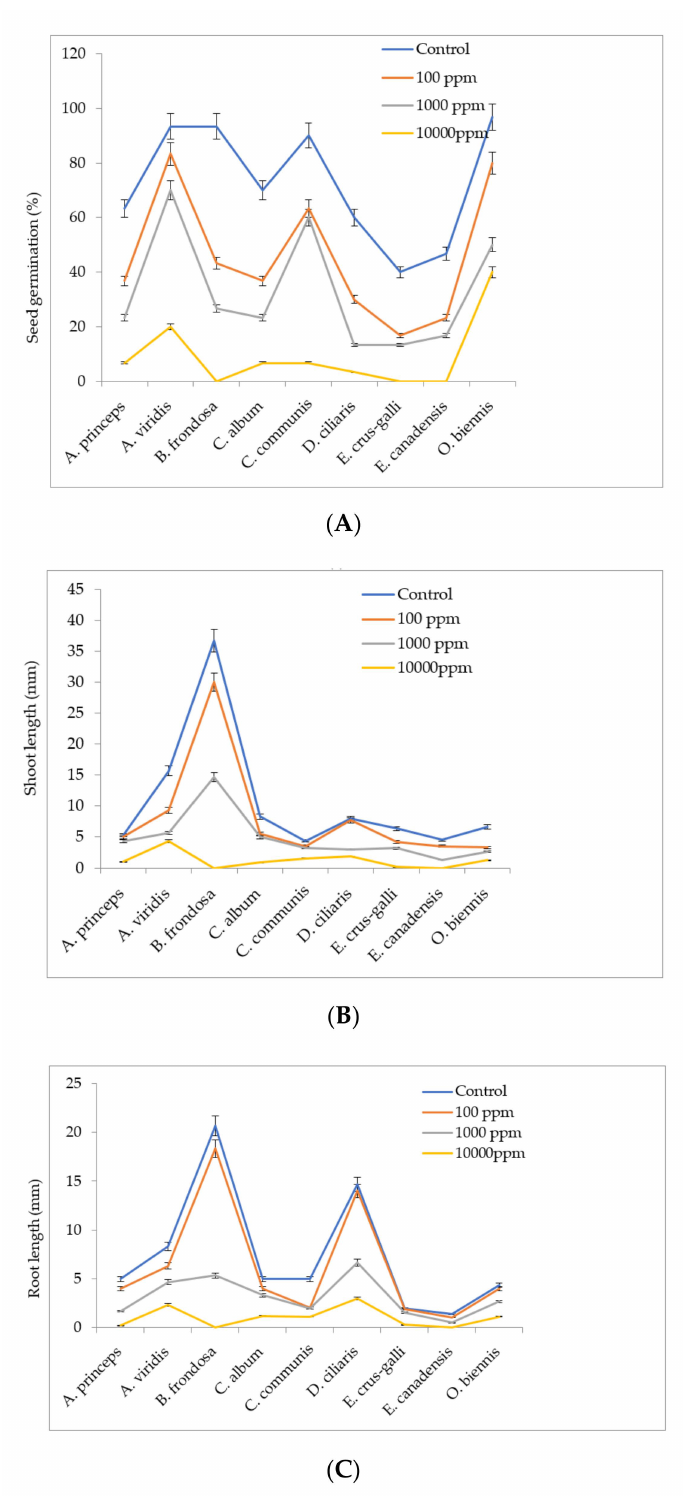
Figure 2. E ff ect of aqueous extract of M. sacchariflorus on ( A ) seed germination (%), ( B ) shoot length (mm), ( C ) root length (mm). Values are reported as mean ± standard deviation of three parallel